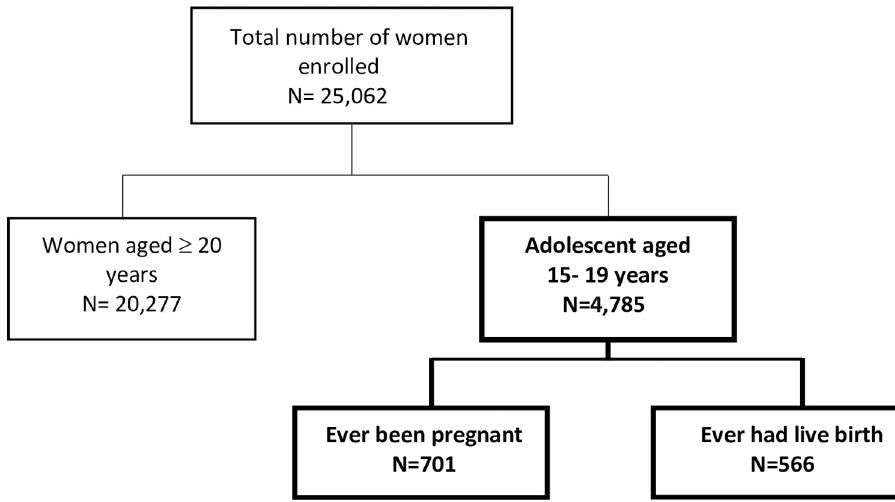
Fig 1. Description of study respondents. Respondents included in this secondary analysis are